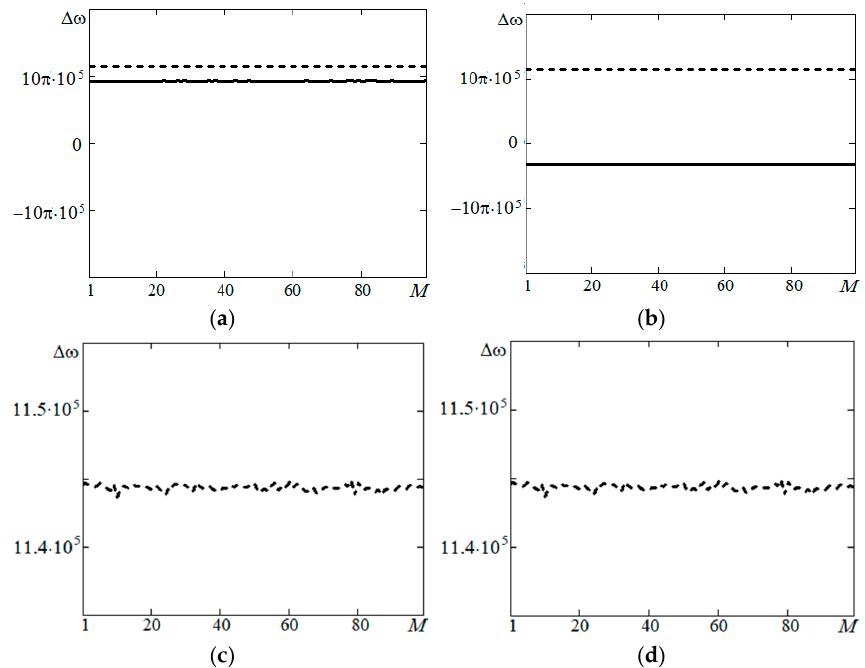
Figure 4. Frequency deviations and frequency deviation estimation error for one of the oscillators in the system for the event 30 oscillators have ∆ ω n > 0. 30 oscillators have ∆ ω n < 0 and 40 oscillators have ∆ ω n = 0, and n > 0: ( a , b ) frequency deviations and frequency deviation estimation error; ( c , d ) oscillator frequency deviation estimation